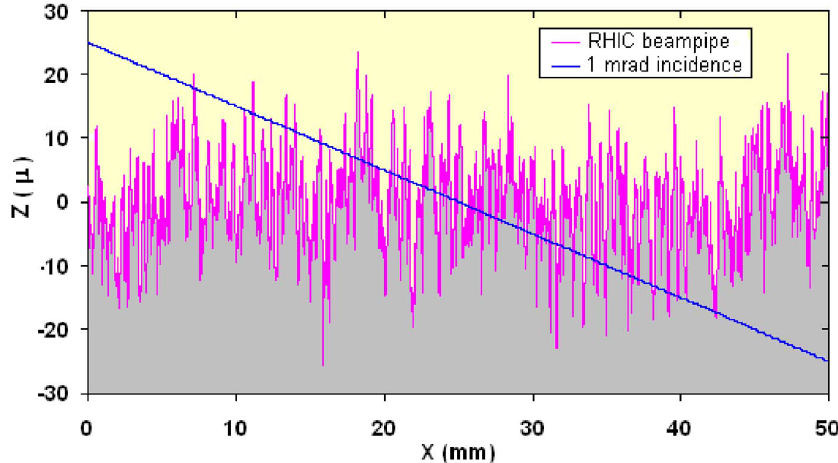
FIG. 6. (Color) Single slice of a 0 : 2 mm (cid:6) 50 mm surface scan of RHIC beam pipe material obtained by Solarius, Inc. [9] using one of their optical profilometers. An ion trajectory incident at 1 mrad is superimposed, showing the multiple transitions between vacuum and solid.